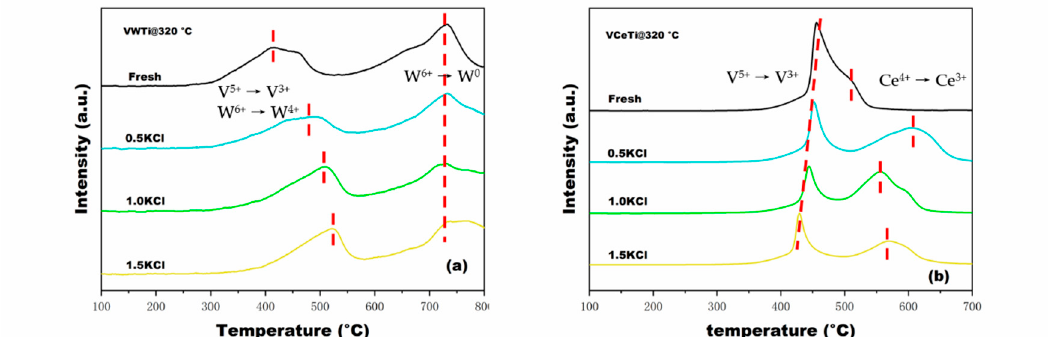
Figure 7. H 2 -TPR profiles of catalysts at three n(K)/n(V) ratios: ( a ) V 2 O 5 -WO 3 /TiO 2 ; and ( b ) V 2 O 5 - Ce(SO 4 ) 2 /TiO 2 .